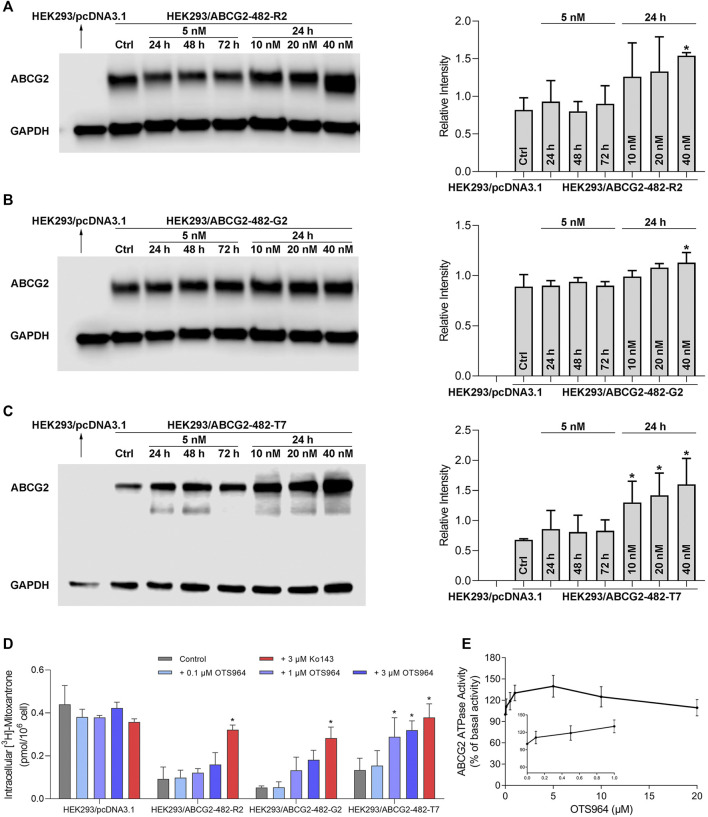
OTS964 enhances ABCG2 protein expression in gene-transfected HEK293 cells expressing ABCG2. The protein expression of ABCG2 in (A) HEK293/ABCG2-482-R2, (B) HEK293/ABCG2-482-G2, (C) HEK293/ABCG2-482-T7 cells after treatment with 5 nM OTS964 up to 72 h or incubation for 24 h with OTS964 at 10 nM, 20 nM or 40 nM concentrations. OTS964 inhibits transport function of ABCG2 in gene-transfected HEK293 cell lines. (D) The tritium-labeled mitoxantrone accumulation in ABCG2-transfected HEK293 cells (HEK293/ABCG2-482-R2, HEK293/ABCG2-482-G2, and HEK293/ABCG2-482-T7) and their corresponding drug-sensitive cells HEK293/pcDNA3.1. Ko143 functioned as a known inhibitor for ABCG2. OTS964 concentration-dependently stimulates ATPase activity of ABCG2 within 20 μM. (E) The effect of OTS964 on ATPase activity of ABCG2 in insect cell membrane vesicles was determined as described in materials and methods section. All data are exhibited as mean ± SD. *p < 0.05 compared with control group.